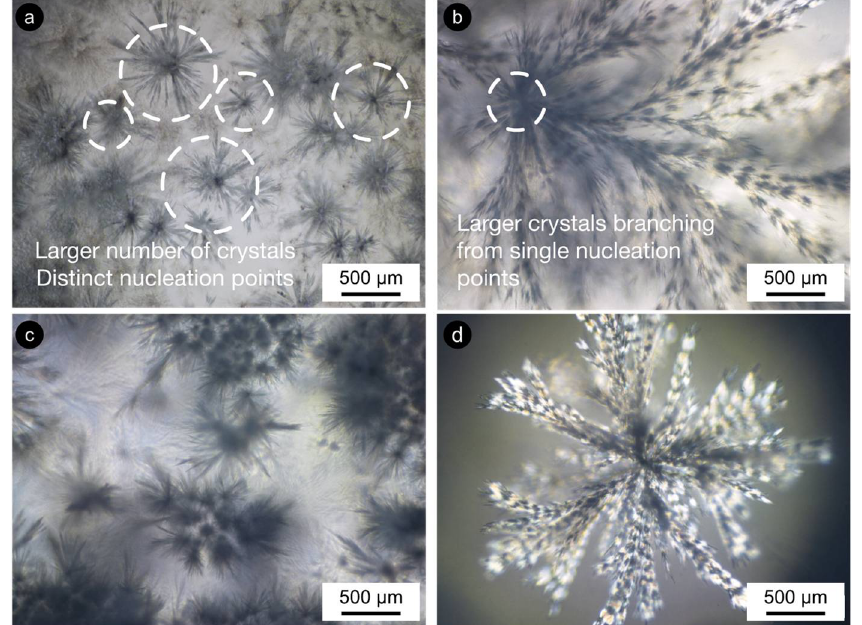
Figure 5. Crystal growth morphology/disposition for STO8 50:50 under ( a ) r1 = 1 °C·min −1 and ( b ) r2 = 7 °C·min -1 (both after 24 h); ( c ) r1 = 1 °C·min −1 and ( d ) r2 = 7 °C·min −1 (both after the first week). Micrographs obtained under polarization with 50× magnification.